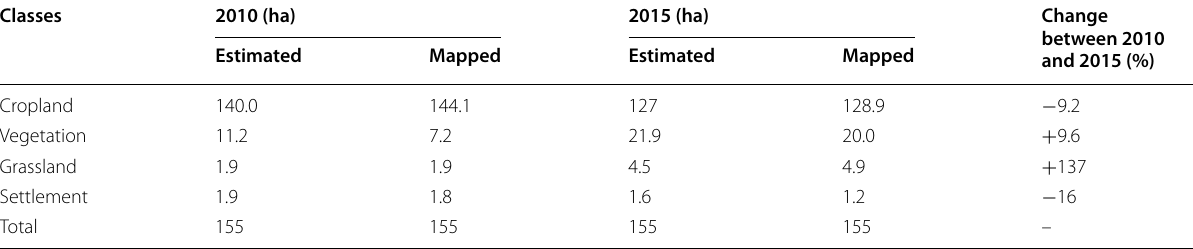
Table 5 Area estimates of each land use class based on reference data (ha) Classes